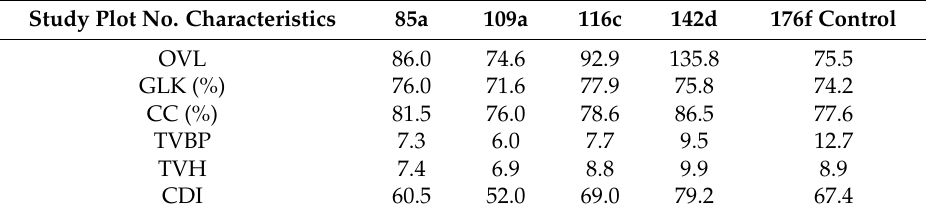
Table 2. Assessment of the quality of the analysed individual sequences based on the characteristics. Study Plot No.